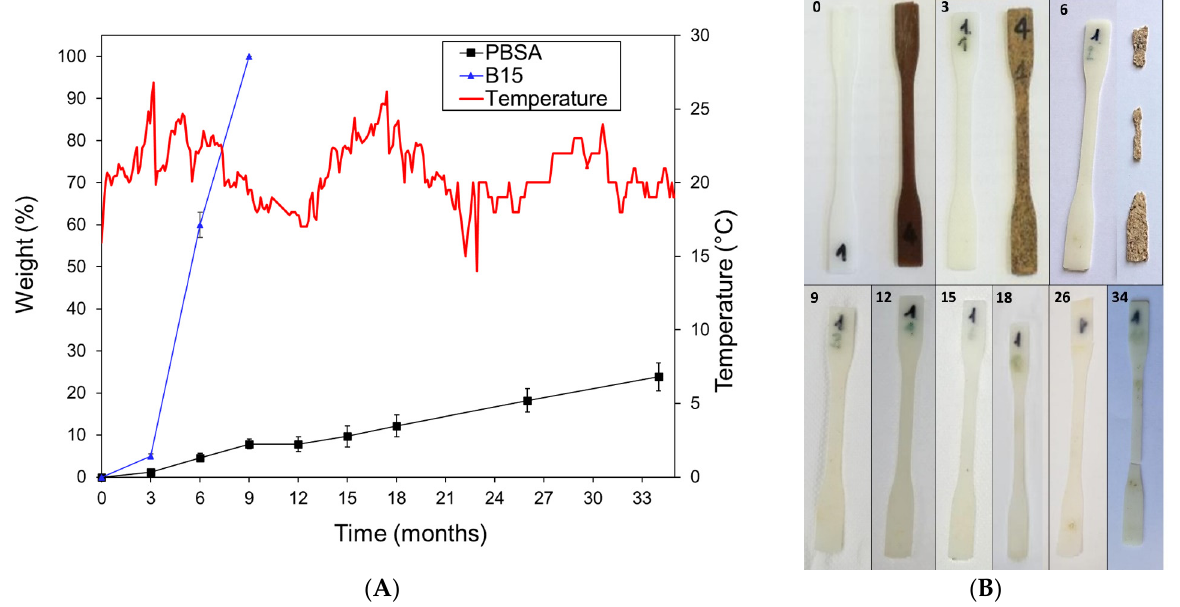
Figure 11. ( A ) The PBSA and B15 weight loss (%) over time during the biodegradation test in the seawater tank. Mean values ± standard deviation of 3 replicates. Average pH 7.8, O 2 concentration 4.1 g/L, and salinity 37.4 g/L). ( B ) Starting dog-bone specimens and after the periodic samplings; the sampling month number is shown at the top.